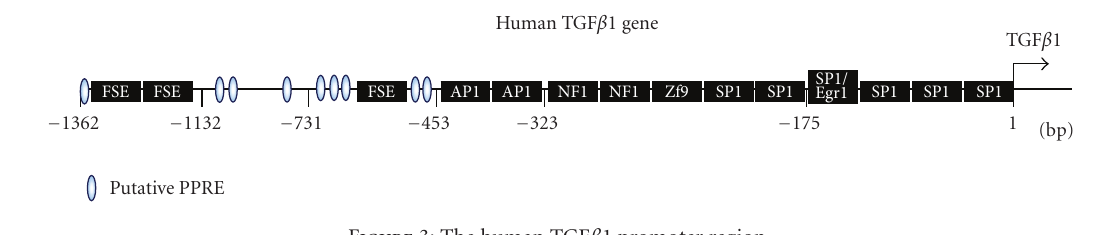
Figure 3: The human TGF β 1 promoter